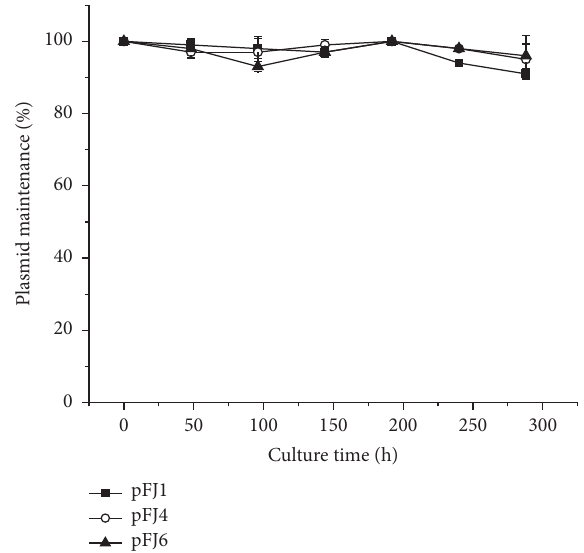
Figure 3: Maintenance of the pFJ1, pFJ4, and pFJ6 shuttle vectors in J7-F cells. J7-F cells containing different shuttle vectors (50 𝜇 L) were diluted in 5mL Halo-2 medium and grown for 24 h. For every two dilutions (12 dilutions in total), aliquots were spread onto Halo-2 plates, and 50 random colonies were selected and spotted onto nonselective 18% MGM plates. Maintenance was measured by calculating the percentage of colonies growing on selective 18% MM